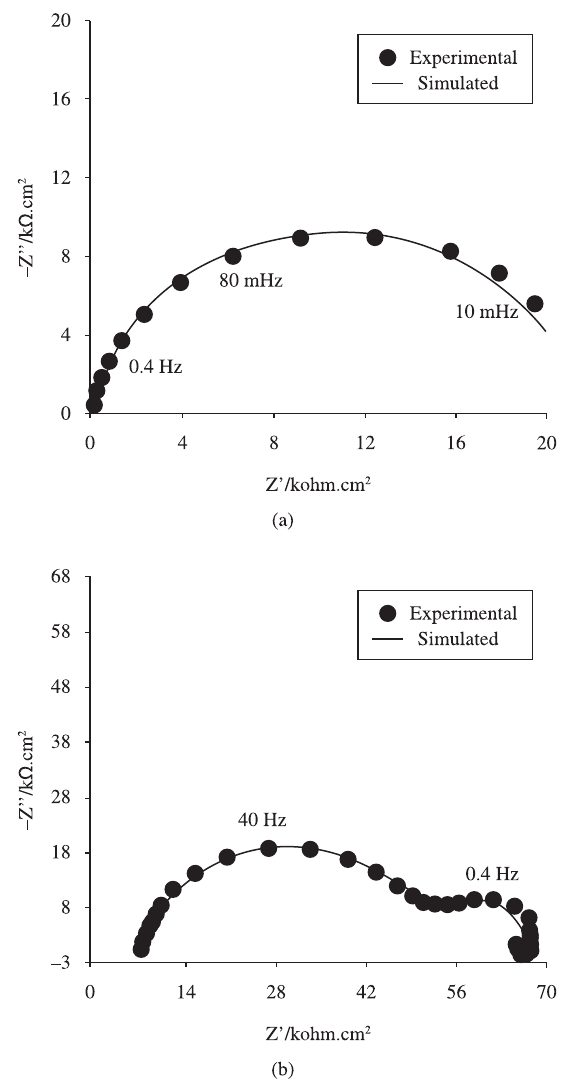
Figure 10. Nyquist plots of Ti6Al4V in citrate buffer at pH 4.0; a) 0.01 M NaF; b) 0.1 M NaF. a dissolution process of the oxide film occurs after longer exposure in the citrate at pH5.0.